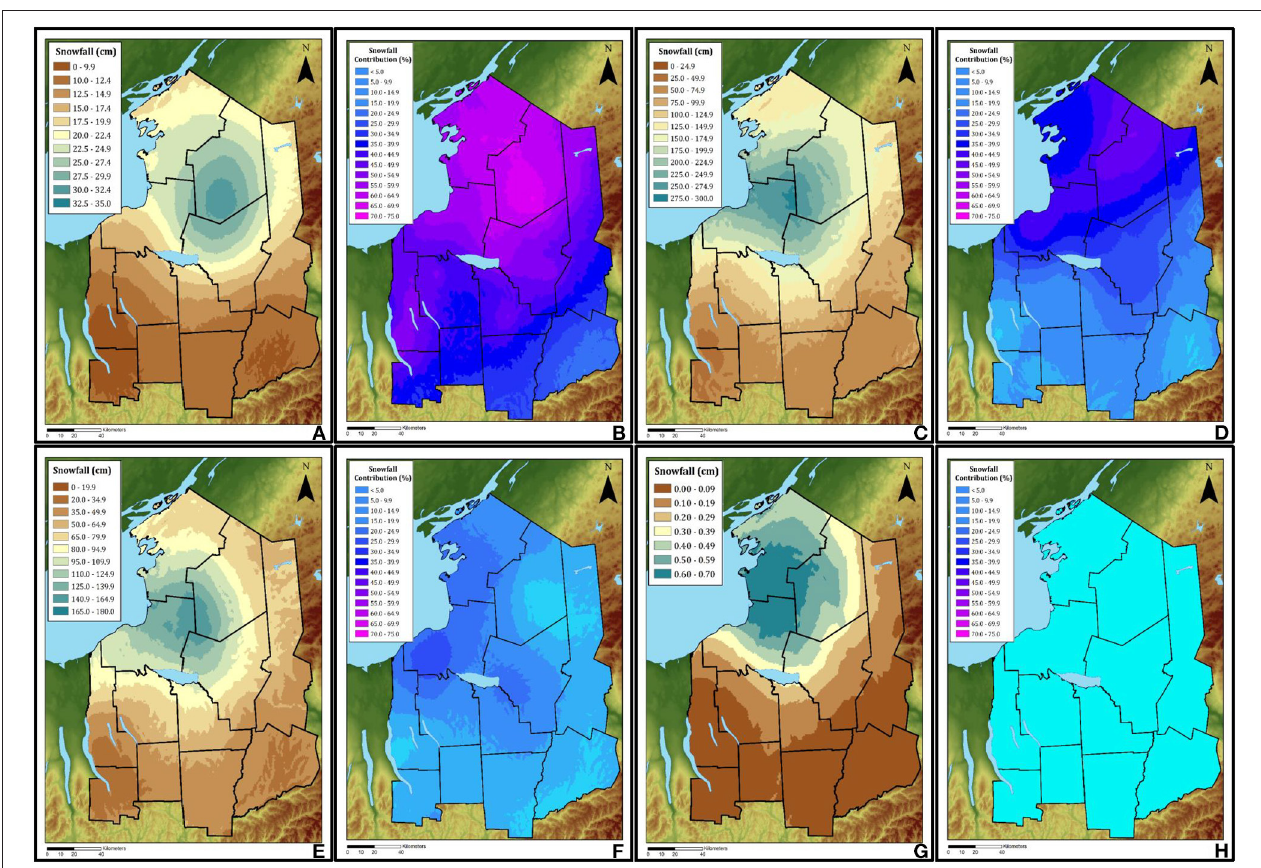
FIGURE 6 | Sub-seasonal snowfall contributions of lake-effect snow within Central New York from 1995/96 to 2014/15. Snowfall contributions (totals and percentage) are mapped for October to November (A,B) , December to January (C,D) , February to March (E,F) , and April to May (G,H) .